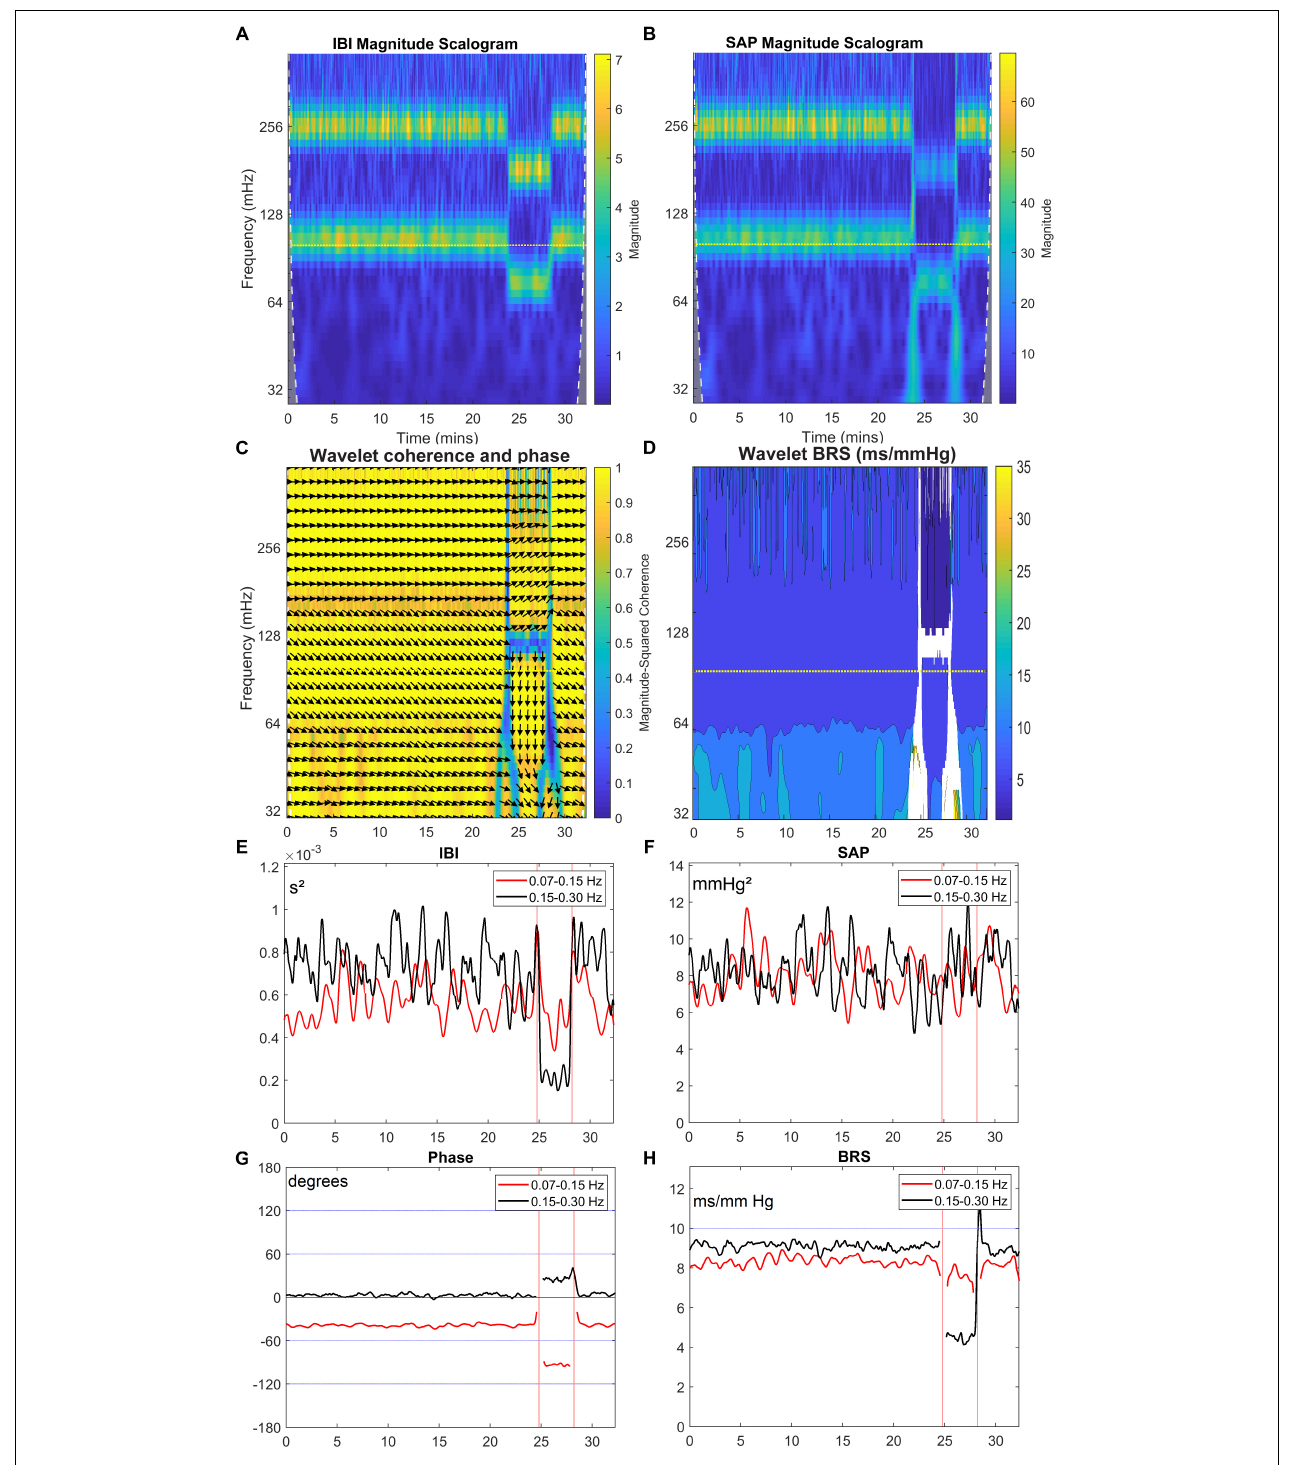
FIGURE 7 | Wavelet analysis of IBI and SAP variability and resulting BRS for simulated data. The layout of this figure is identical to Figure 3 . The colors in the upper panels show the spectral power for each frequency and for each point of time, (A) for IBI and (B) for SAP. (C) shows the wavelet coherence r 2 (color) and phase (arrows) between SAP and IBI. In (D) , the BRS is calculated from the data in (A,B) . In (E,F) , the mean spectral power in the LF band (red line) and in HF band (black line) is shown for IBI and SAP variability. (G,H) show the mean phase between SAP and IBI and the mean BRS for both frequency bands. A negative phase implies SAP-variations leading IBI-variations. The imposed frequencies are 0.1 and 0.25 Hz but due to our beat-to-beat approach the apparent frequencies are slightly higher during the supine period, and lower during the (shorter) HUT